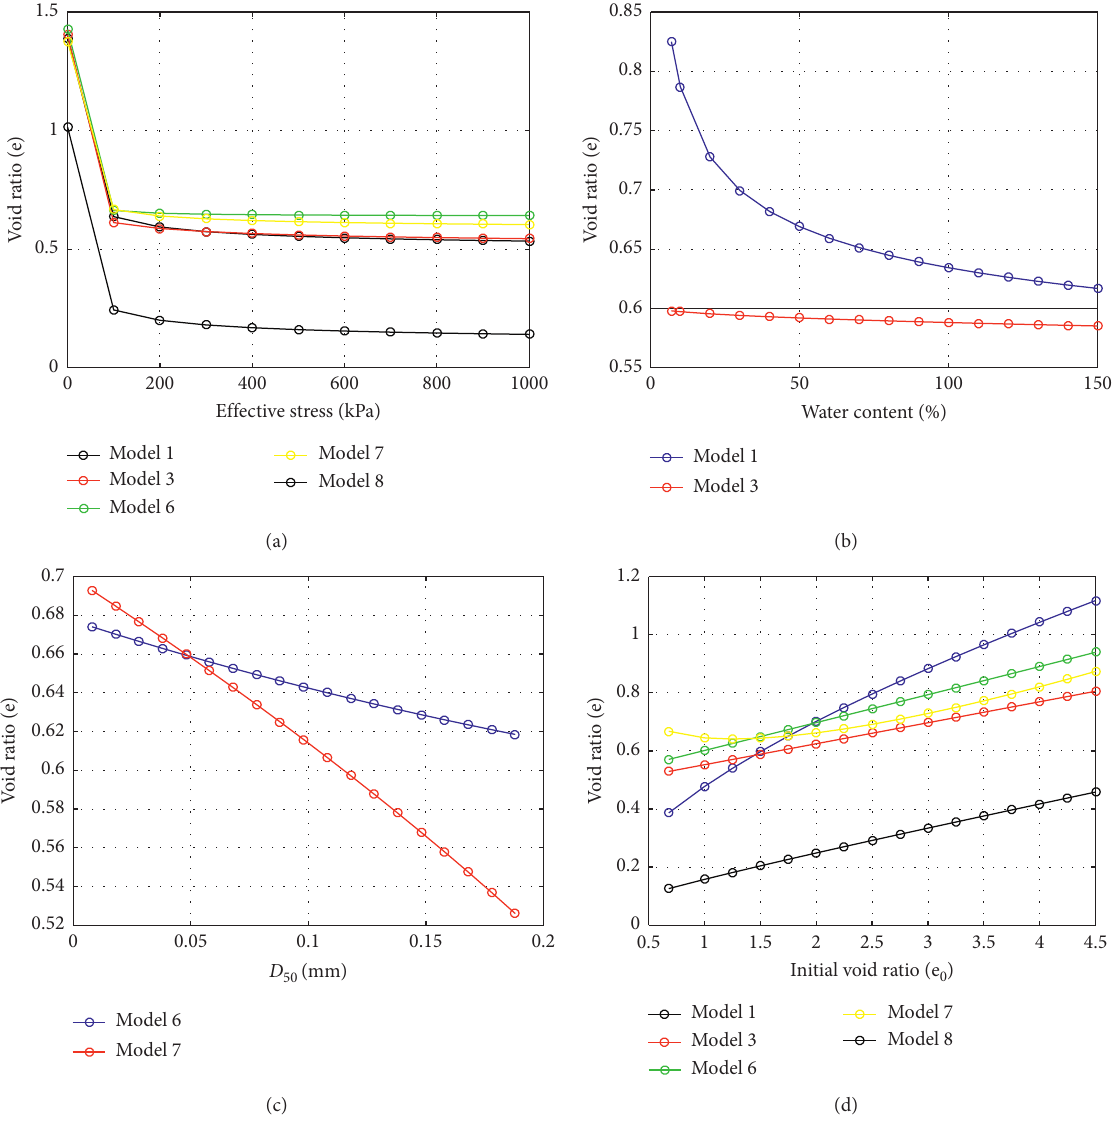
Figure 5: Variation of the predicted void ratio ( e ) versus (a) effective stress (kPa), (b) water content (%), (c) D ratio ( e 0 ) for GEP